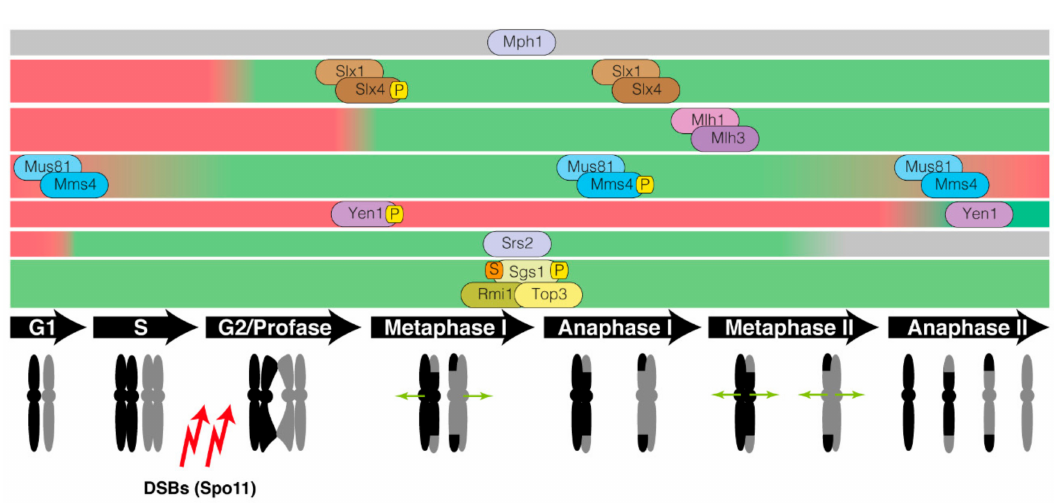
Figure 3. Schematic representation of the temporal regulation of enzymatic complexes involved in the processing of recombinant structures in the meiotic program. The diagraph represents the temporal activation (green bars) and inactivation (red bars) of each complex during meiosis. Di ff erent post-translational modifications, such as phosphorylation (P), SUMOylation (S) and ubiquitylation (U) are portrayed. Green and red bars represent active and inactive states, respectively. Grey bar denotes lack of information related to the temporal regulation of the enzymatic